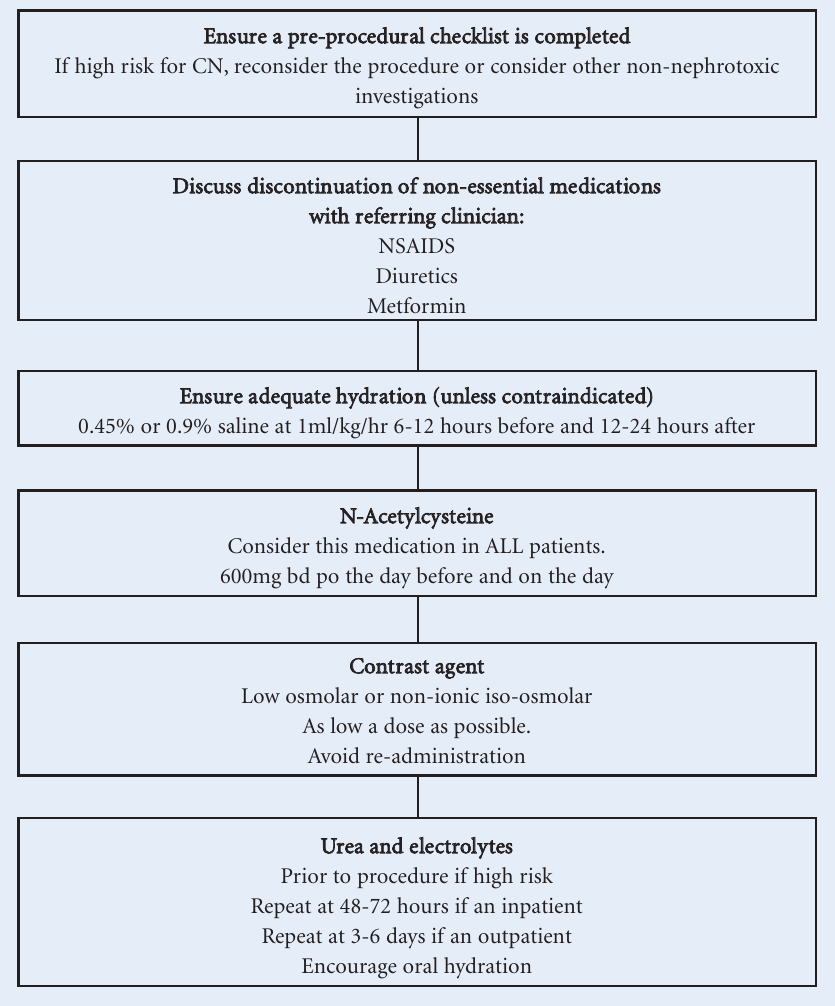
The algorithm proposed in Fig. 1 sug-